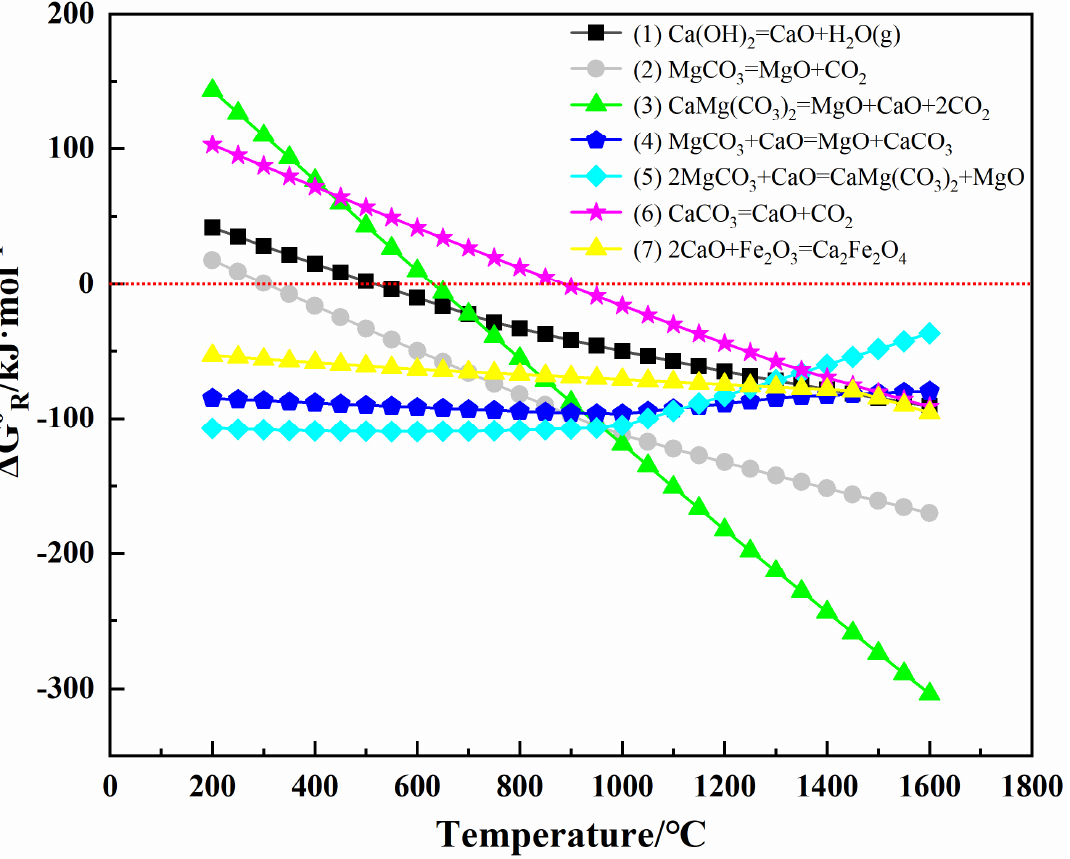
Figure 7. Relationships between Gibbs free energy change and the temperatures of the reactions.